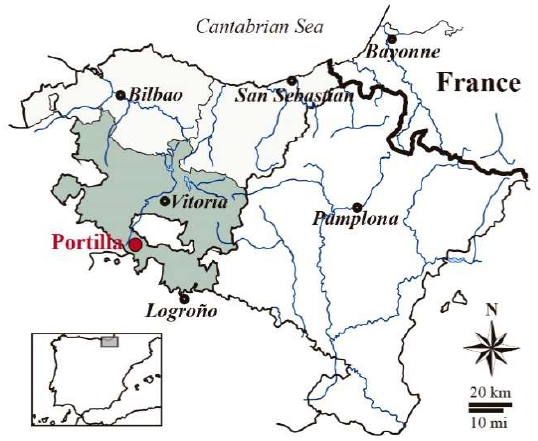
Figure 1. Geographic location of Portilla Castle (Álava, Spain).